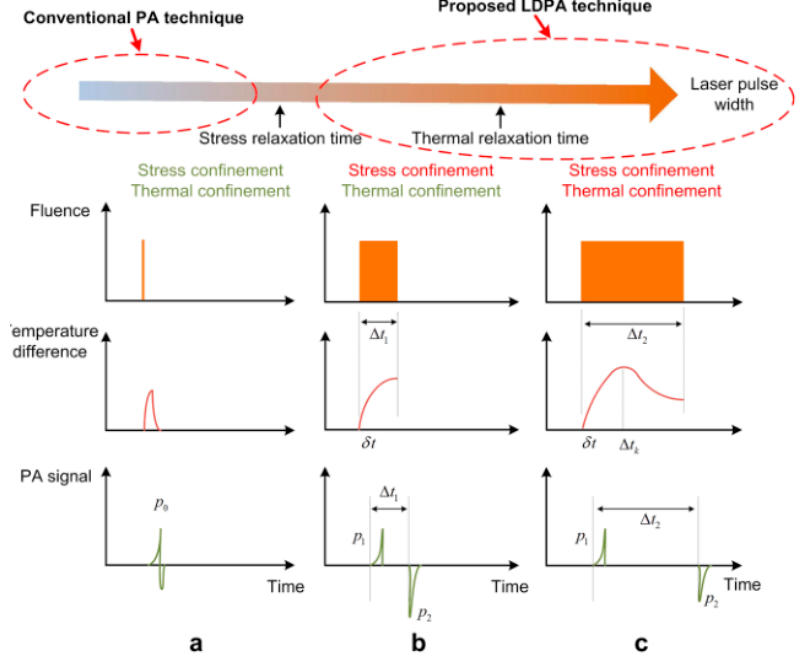
Figure 11. The fluence pattern, temperature change and PA signal waveform of ( a ) conventional short laser pulse-induced PA effect with both stress and thermal confinements satisfied; ( b ) long laser pulse induced dual PA nonlinear effect with only thermal confinement satisfied, and ( c ) even longer laser pulse without thermal confinement. Reproduced with permission from Ref. [71].